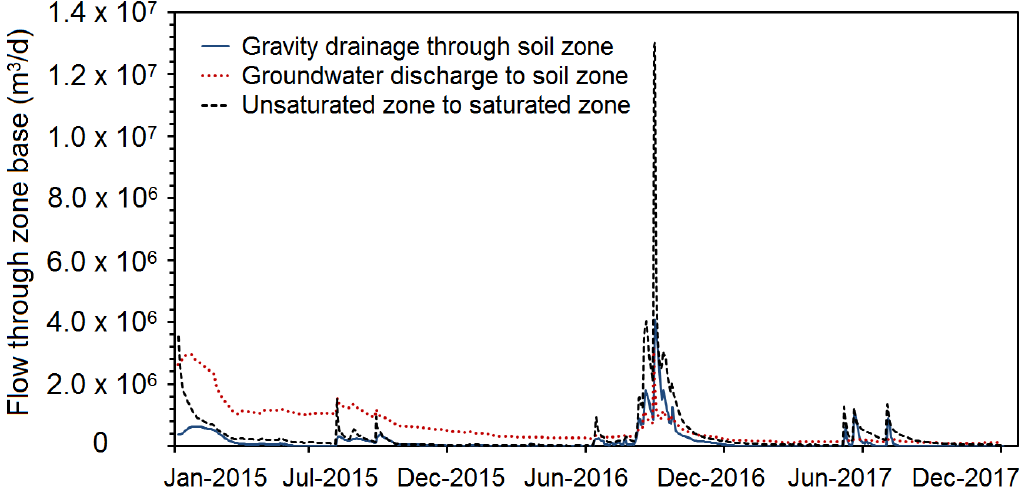
Figure 13. Temporal variations of the volumetric flow rates near the interface of the soil zones in the